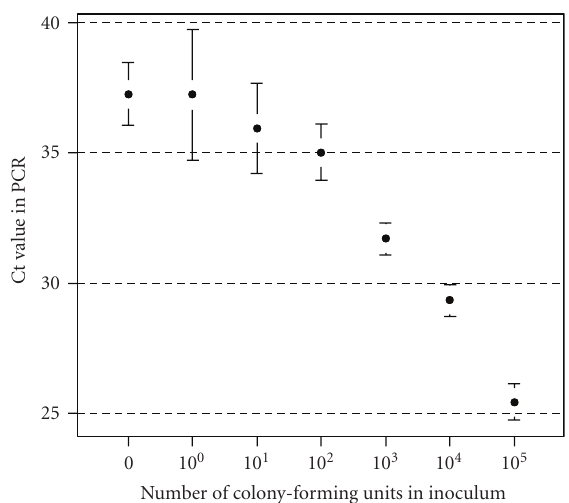
Figure 1: Quantification of Mycobacterium avium subsp. paratu- berculosis (MAP) cell number by IS 900 realtime PCR inoculating tenfold dilution of MAP ATCC 19698 artificially contaminated bovine muscle